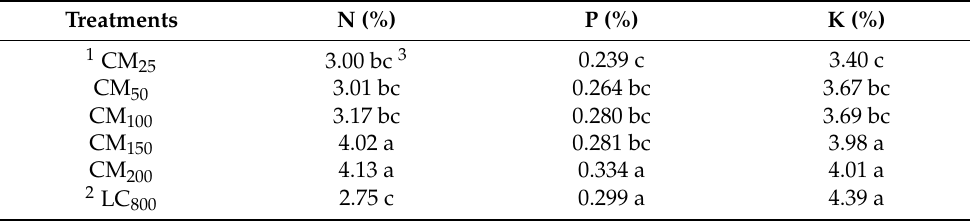
Table 2. The nutrient concentrations in the leaves of Pak Choi after the application of organic fertilizers.